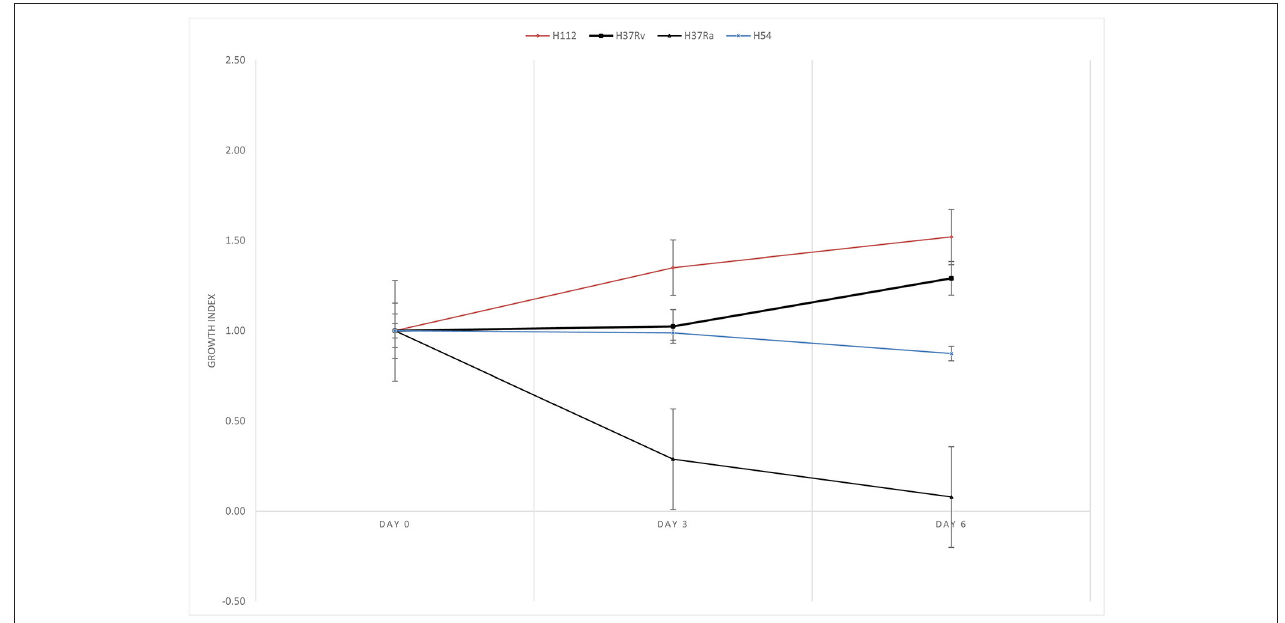
FIGURE 2 | Reassessment of enhanced intracellular growth in THP-1 macrophage. Growth indexes showing multiplication of M. tuberculosis strains inside THP-1 macrophage. Higher growth index of hypervirulent strain H112 (red) relative to reference virulent strain H37Rv (black with squares), avirulent strain H37Ra (black with triangles), and control strains H54 (blue) were clearly demonstrated. Growth index was determined as mean CFU per ml at day 0, 3, 6 divided by mean CFU per ml at day 0, respectively. The lines represent mean of triplicate experiments.